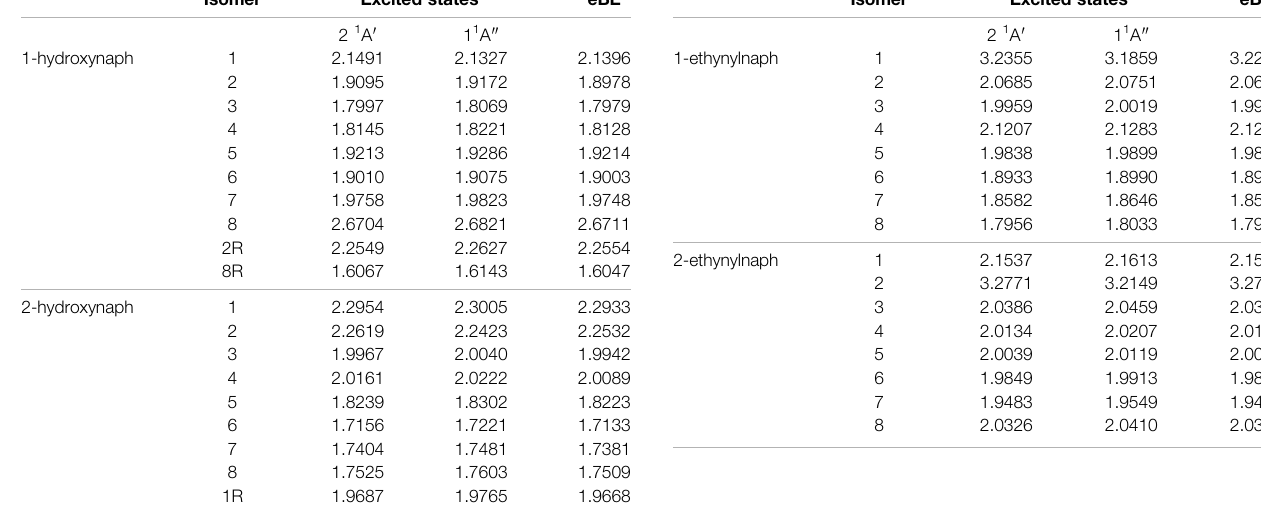
TABLE 5 | The singly deprotonated hydroxynaphthalene anion derivatives eBEs and transition energies. Isomer